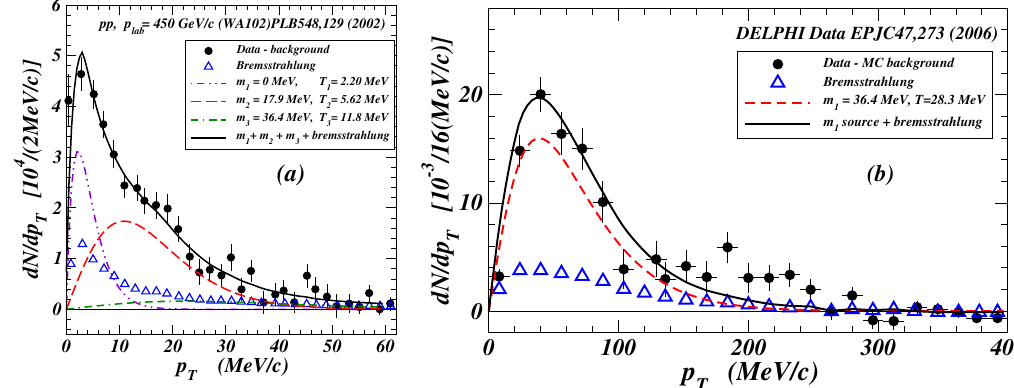
Figure 2 . (a) Anomalous soft photon dN=dp T data from pp collisions at p lab = 450 GeV/c obtained by Belogianni et al. [27]. (b) Anomalous soft photon dN=dp T data from the DELPHI Collaboration for e + e (cid:0) annihilation at the Z 0 mass of 91.18 GeV [28]. The solid circular points represent the experimental data after subtracting the experimental background, and triangle points represent the deduced bremsstrahlung contributions. The total theoretical yields in the thermal model from produced bosons and the additional bremsstrahlung contributions are shown as solid curves. The component yields from di(cid:11)erent masses of the thermal model are shown as separate